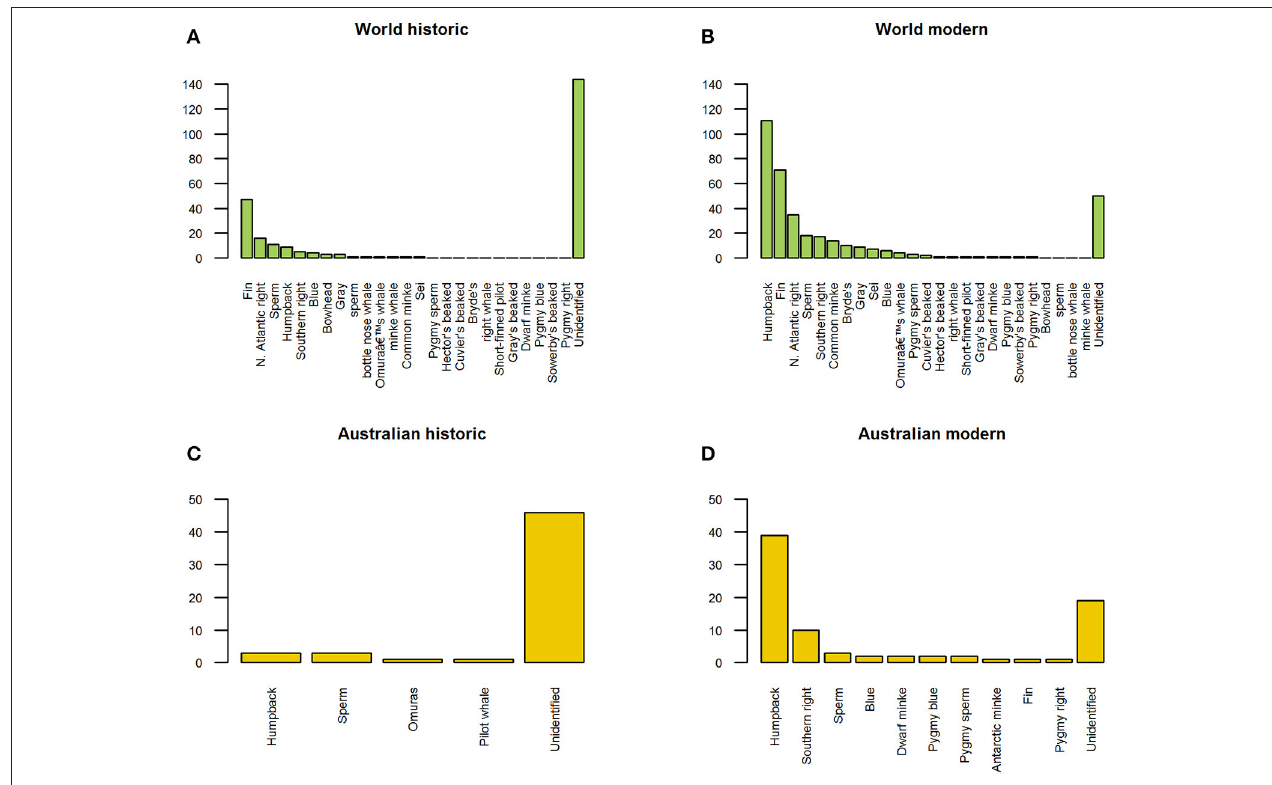
FIGURE 7 | Comparison of vessel strike records by species for: (A) Worldwide historic (up to 1997) (B) Worldwide modern (1997 onwards) from IWC (2010) and potential new records (C) Australian historic and (D) Australian